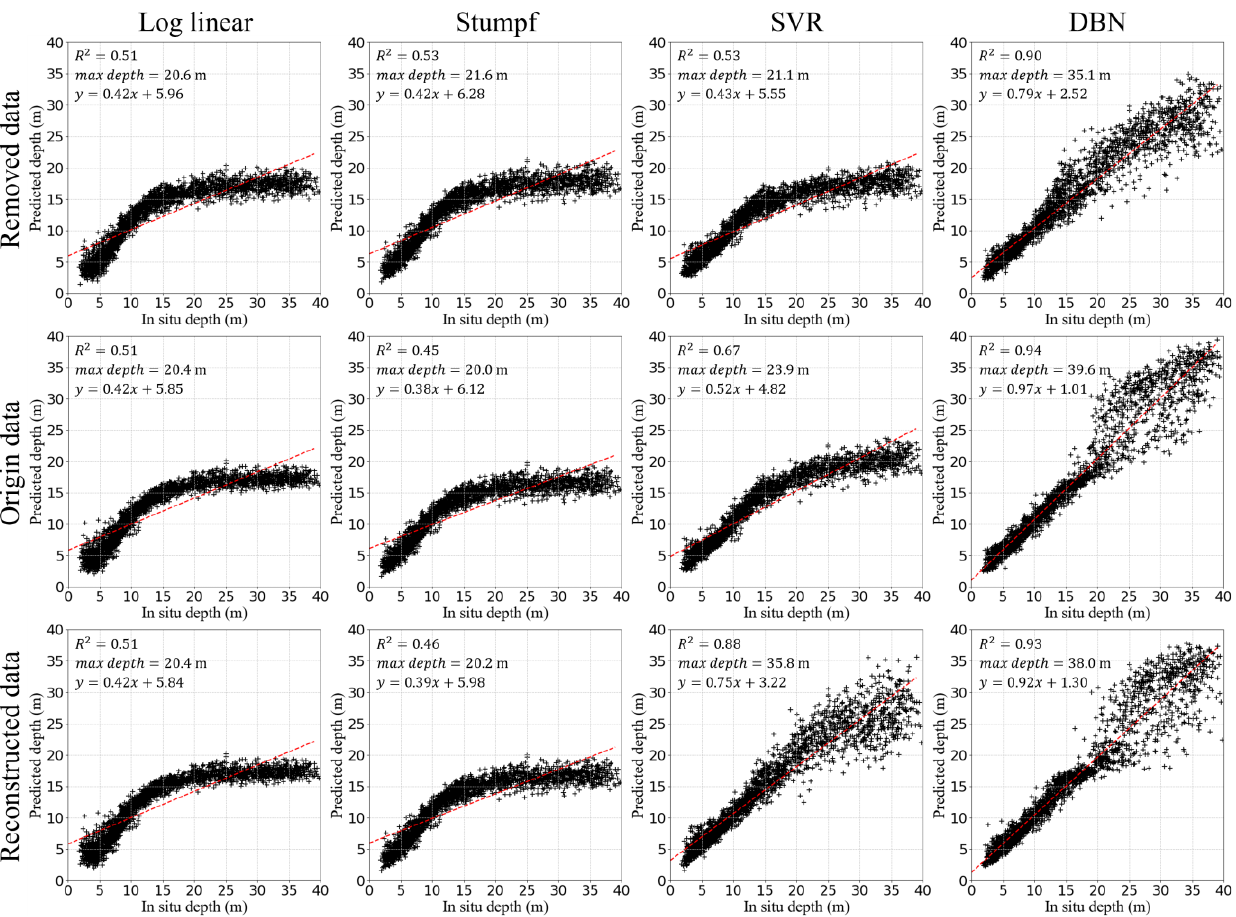
Figure 10. Scatterplots of predicted water depth versus in situ water depth derived from four models with three groups of data in the Oahu Island study area.